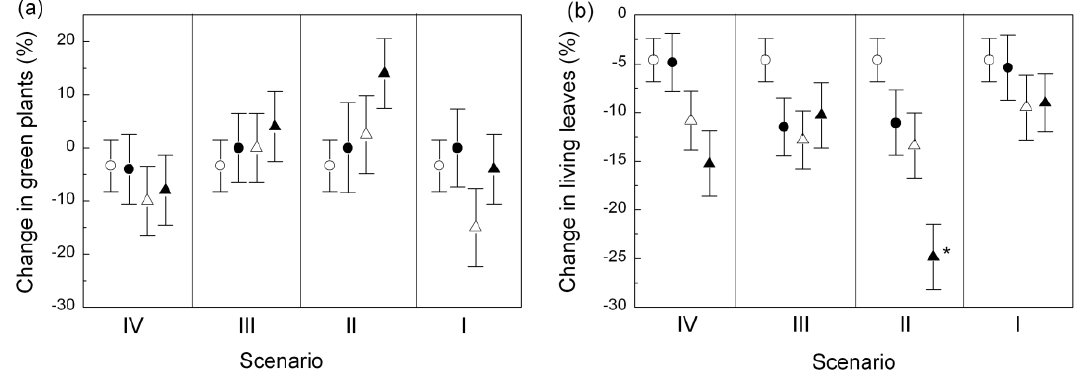
Fig. 5. Influence of the second extreme on (a) whole-plant senescence and (b) leaf survival per scenario. Control = open circles, drought = closed circles, heat = open triangles, drought + heat = closed triangles. Asterisks next to symbols indicate significant differences ( P <0.05) between treatment and control. Scenario IV = 42-day interval between subsequent events, scenario III = 25-day interval, scenario II = 14-day interval, scenario I = single event.